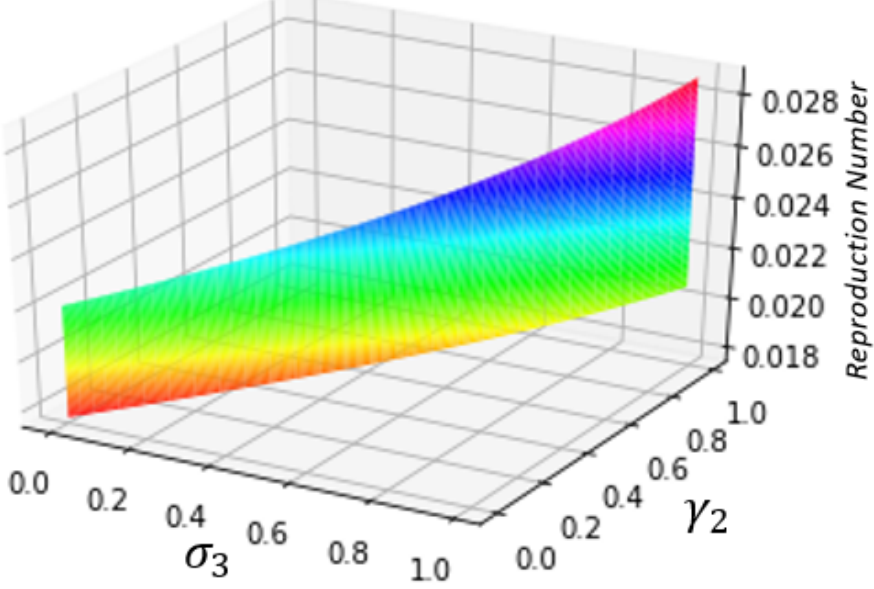
Fig. 14 Showing The Effect of σ 3 and γ 2 on the Reproduction Number Using the Parameter Values on Table 1 when σ 3 = γ 2 = [0 , 1]